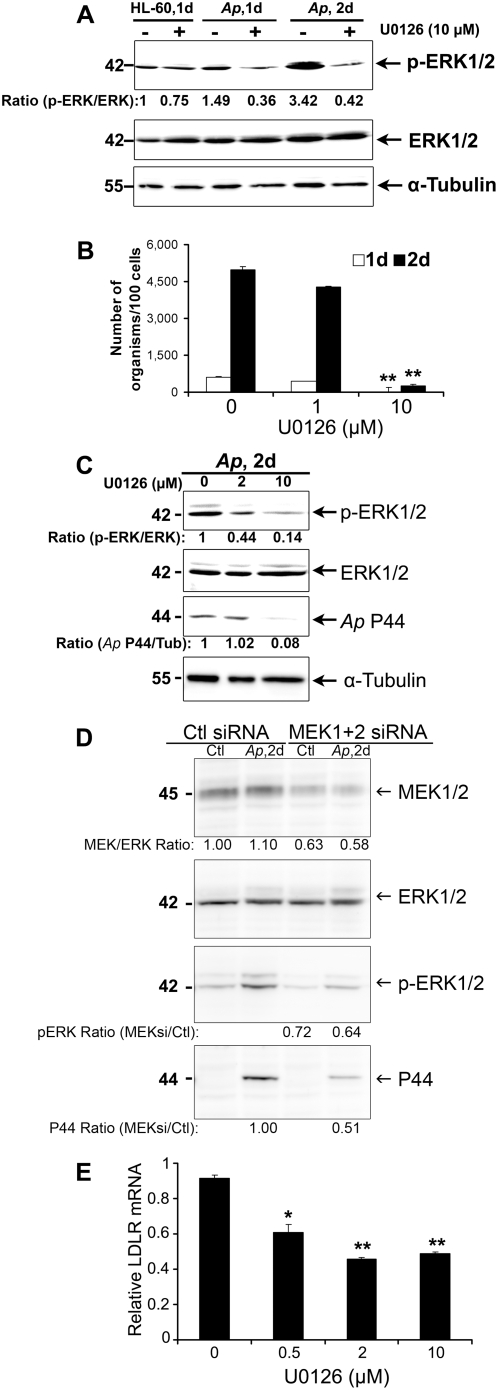
ERK signaling pathway is involved in the LDLR up-regulation upon A. phagocytophilum infection.(A) Western blot analysis was performed using antibodies specific to either the phosphorylated or total ERK1/2. Uninfected and A. phagocytophilum–infected HL-60 cells with or without 10 µM ERK inhibitor U0126 treatment were collected at the indicated time points. α-Tubulin was used as the protein loading control to normalize each sample. The values under the bands show the ratios of band intensities of p-ERK and ERK. Ap, A. phagocytophilum. (B) Bacterial numbers per 100 cells treated with the indicated concentrations of U0126 were determined on days 1 and 2 p.i. (C) Western blot analysis of A. phagocytophilum–infected HL-60 cells on day 2 p.i. treated with the indicated concentrations of U0126 was performed using antibodies specific to phosphorylated or total ERK1/2, or A. phagocytophilum outer membrane protein P44. α-Tubulin was used as the protein input control to normalize each sample. The values under the bands show the ratios of band intensities of p-ERK and P44, normalized to total ERK or α-tubulin, respectively. Data are representative of three independent experiments. (D) HL-60 cells were transfected with control (Ctl) or double-stranded siRNA specific targeting the genes encoding MEK1 and MEK2 (MEK1+2) (3 µg/2×106 cells) using the Amaxa Nucleofection system. Two days after transfection, host cell-free A. phagocytophilum was added to the cells and incubated for additional 2 days. One aliquot of samples were lysed and subjected to Western blotting using antibodies against MEK1/2, ERK1/2, phospho-ERK1/2, and A. phagocytophilum P44 protein. The relative protein amount of MEK1/2, phospho-ERK1/2, and P44 were determined using total ERK1/2 as loading control by densitometry analysis. The values under the bands show the relative ratios of band intensities, with the ratios of those from samples nucleofected with control siRNA arbitrarily set as 1. Results are representative of three independent experiments. (E) LDLR expression in A. phagocytophilum–infected HL-60 cells on day 2 p.i. treated with the indicated concentrations of U0126 was determined by quantitative RT-PCR. Data are expressed as mean±standard deviation (n = 3) and are representative of two independent experiments. *, p<0.05 (unpaired two-tailed t test); **, p<0.01 (unpaired two-tailed t-test).